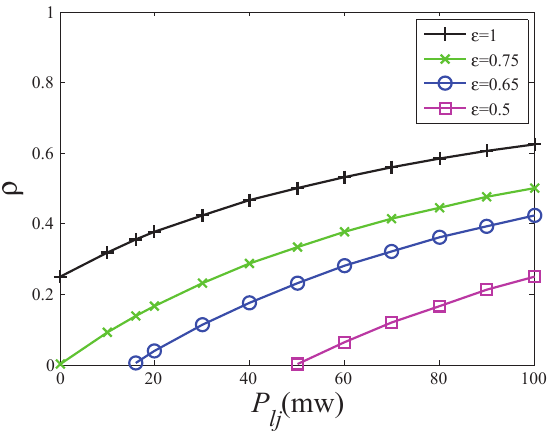
Figure 10. The impact of energy converting coefficient on splitting